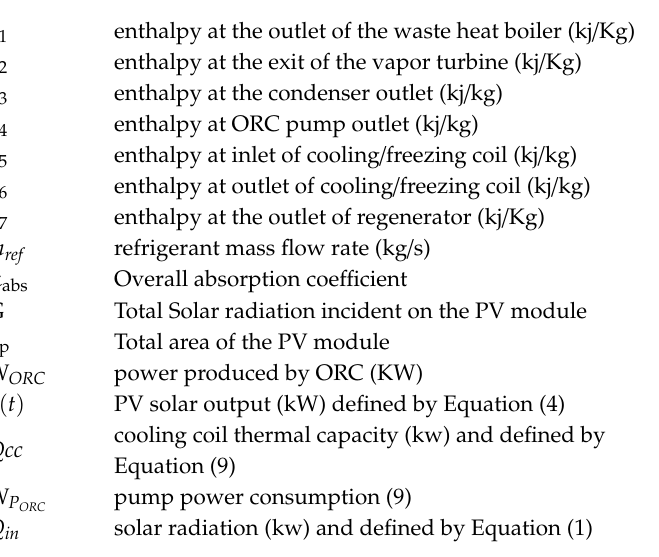
Table S1: Properties of